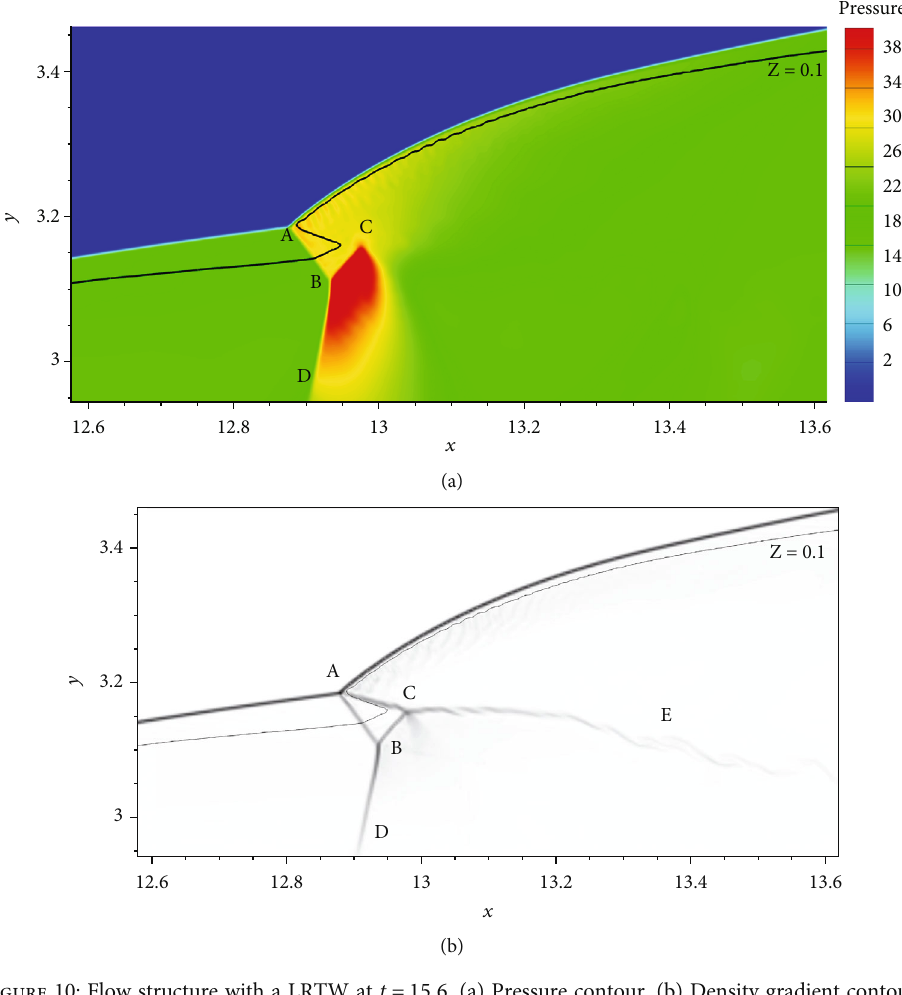
Figure 10: Flow structure with a LRTW at t = 15 : 6 . (a) Pressure contour. (b) Density gradient contour.